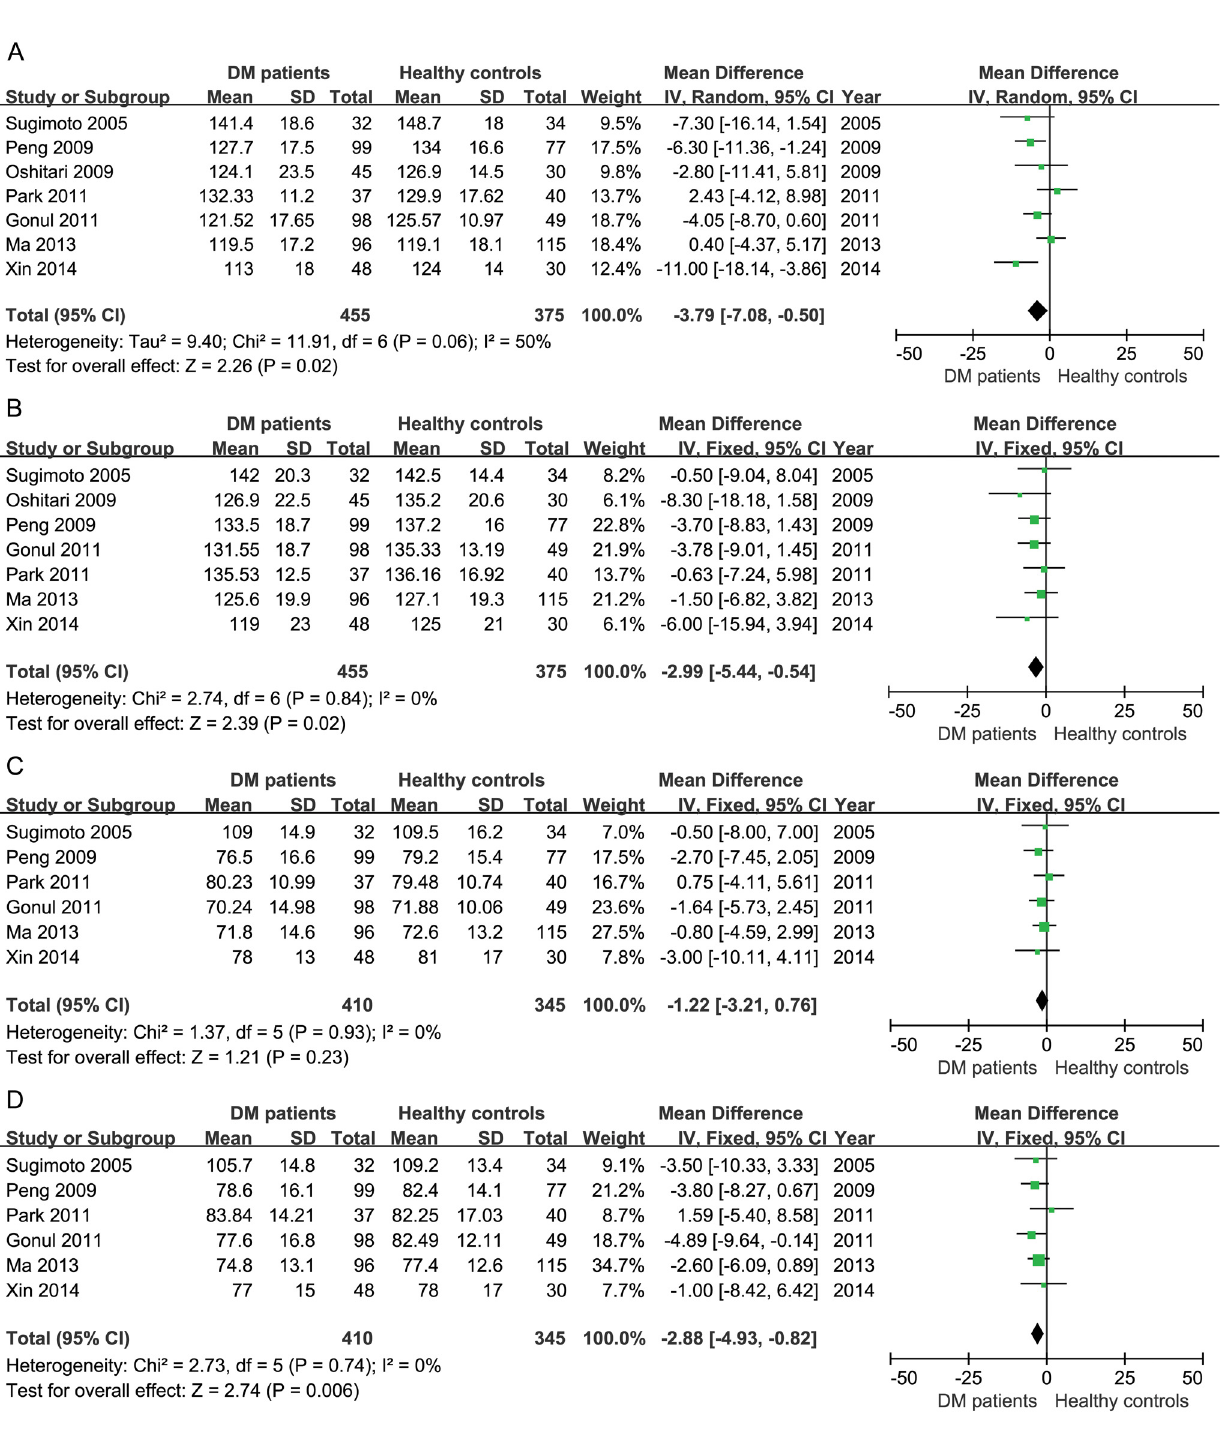
Fig 5. Meta-analysis of RNFL thickness in four quadrants in studies using OCT. A, superior; B, inferior; C, temporal; D,